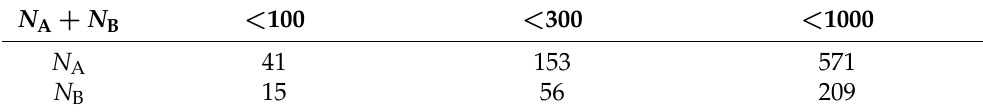
Table 2. Turns number for shift angle equal to 15 ◦ (conversion